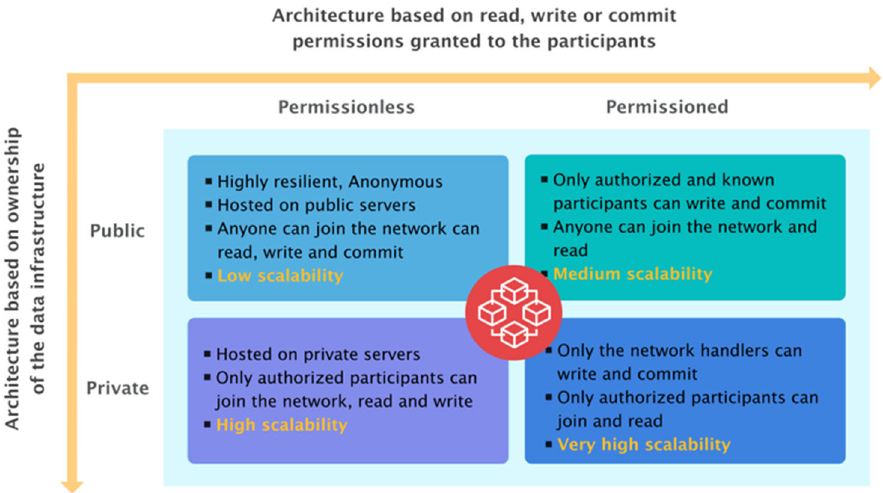
Figure 5. Blockchain scalability trilemma .